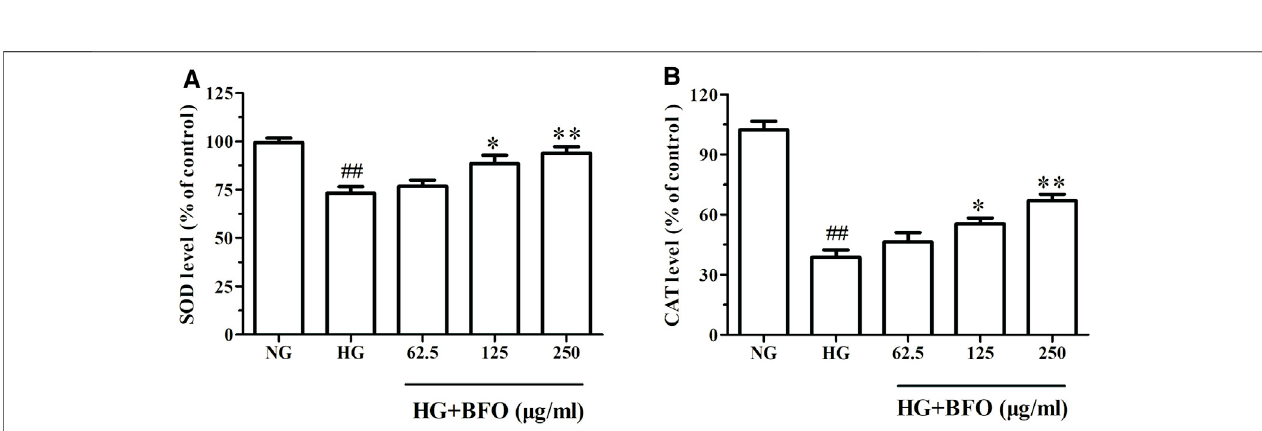
FIGURE6| EffectofBFOonSOD (A) andCAT (B) levelsinNRK-52Ecells.Alldataareexpressedasthemean ± SD. ## p < 0.01vs.normalglucose(NG),* p < 0.05 vs. HG, ** p < 0.01 vs. HG.